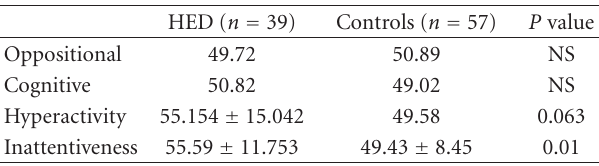
Table 5: Mean T-scores on CPRS-R:S in children with HED and control group.